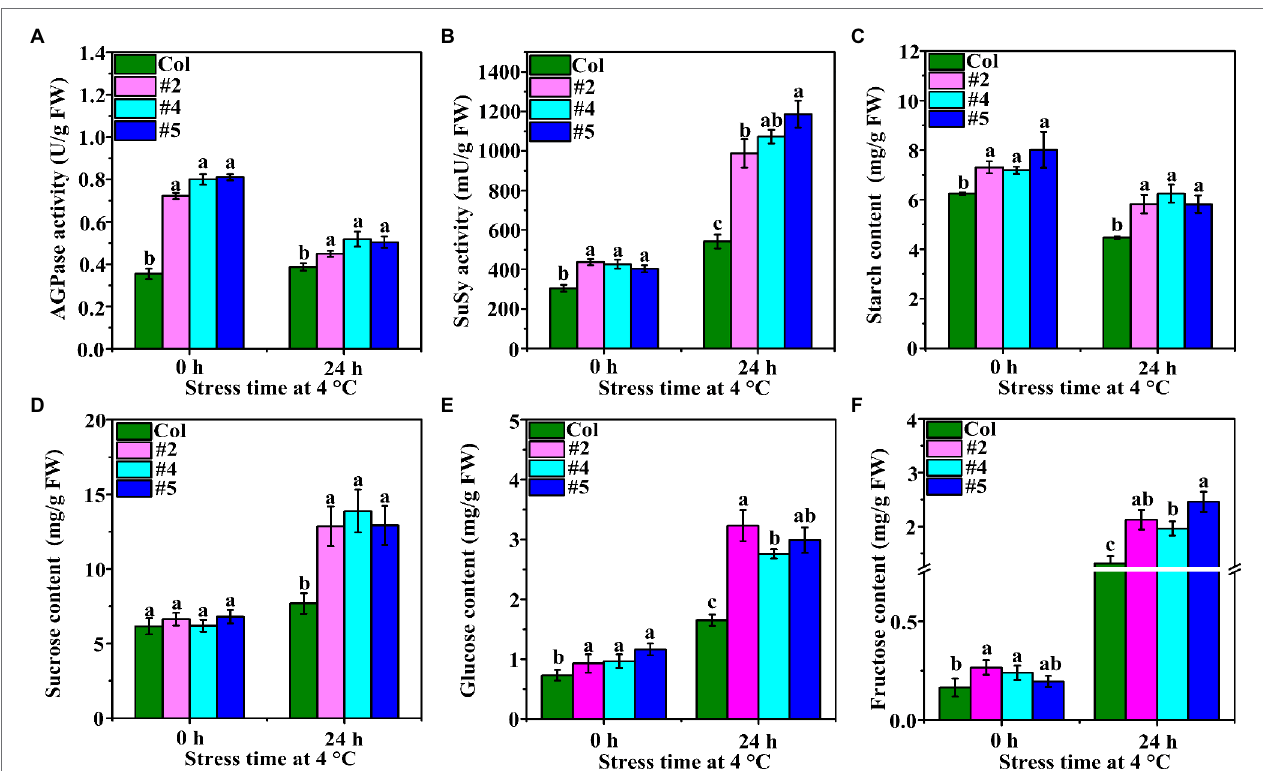
FIGURE 3 | Changes in AGPase and SuSy enzyme activities and starch and soluble content. (A,B) The changes in AGPase and SuSy activities in Col and VaAPL1 -overexpressing A. thaliana plants at 4 ° C after 0 h and 24 h. (C) The changes in starch content in Col and VaAPL1 -overexpressing A. thaliana plants at 4 ° C after 0 h and 24 h. (D–F) The changes in sucrose, glucose and fructose content in Col and VaAPL1 -overexpressing A. thaliana plants at 4 ° C after 0 h and 24